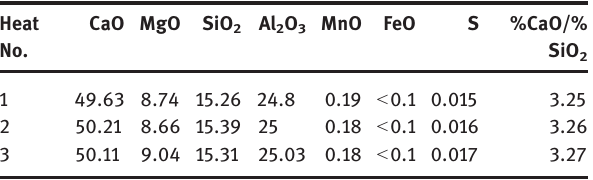
Table 3: Chemical composition of slag samples,